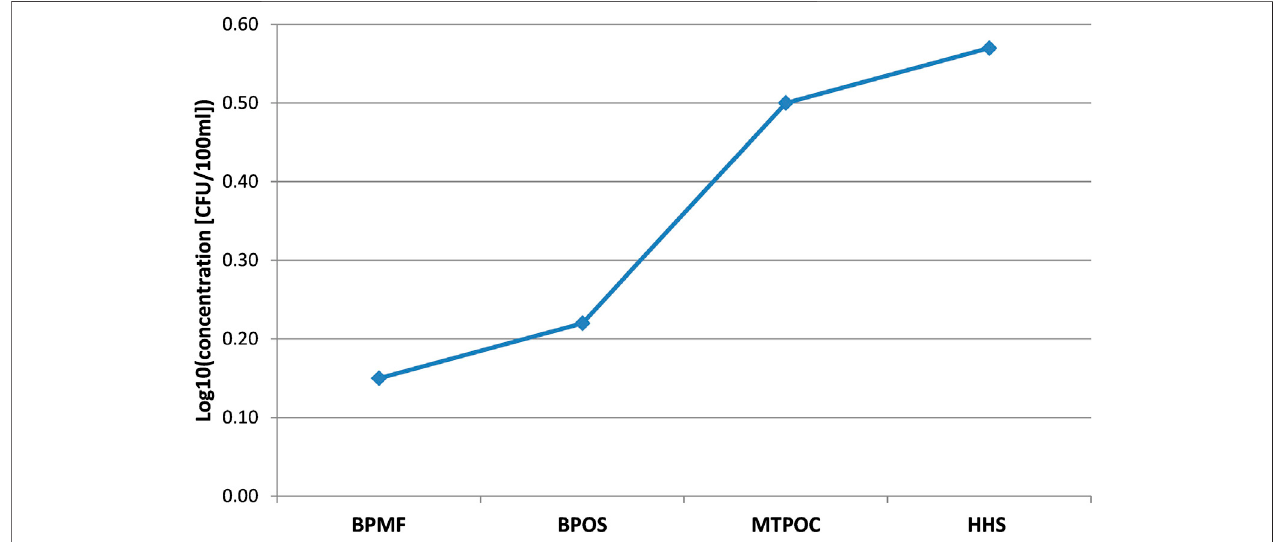
FIGURE 2 | Mean log concentrations of E.coli (CFU/100 ml) measured in samples from BPMF, BPOS, MTPOC,and from household storage for consumption (HHS).